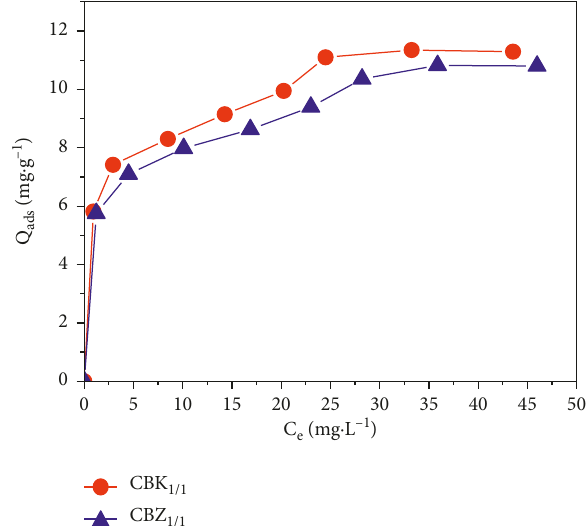
Figure 10: Effect of initial concentration on the adsorption of indigo carmine. Experimental conditions: m � 100mg; V � 20mL; pH � 2; t � 80 min; speed � 200rpm at room temperature.